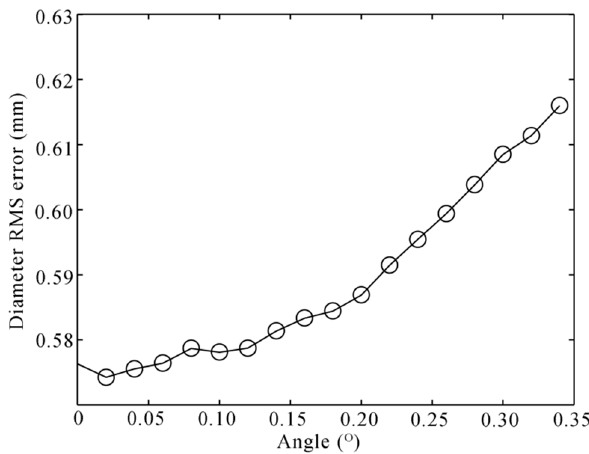
Figure 17. Diameter RMS error to the angle of bending with the geometrical error.